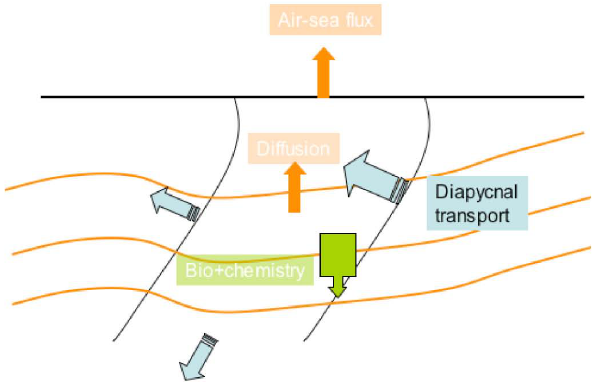
Fig. 4. Sketch of a tracer C balance in an isopycnal framework. Light blue arrowes indicate the advective